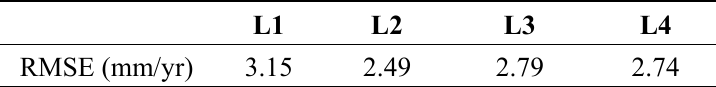
Table 1. Root mean square error (RMSE) of the subsidence differences based on the four chosen profile